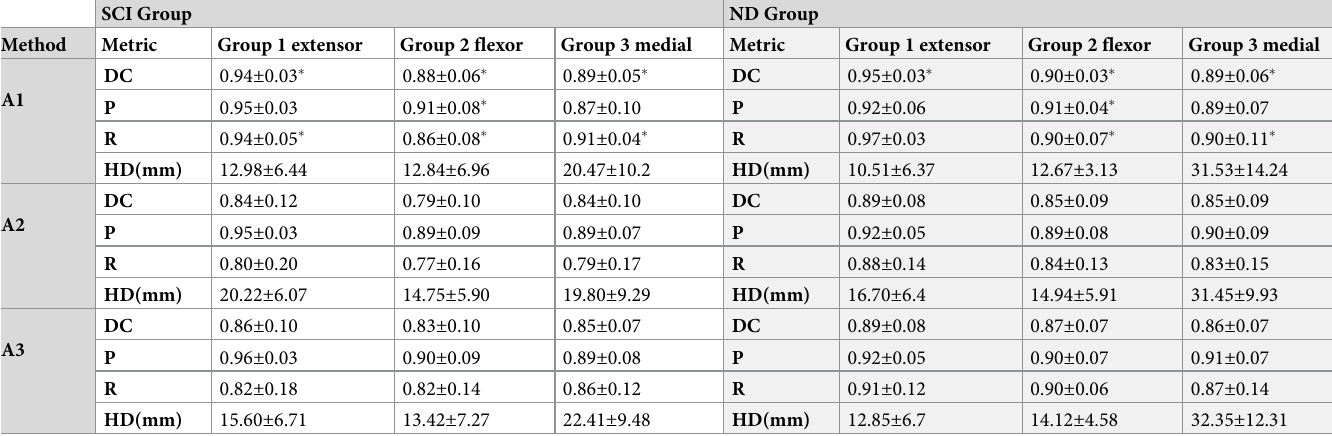
Table 2. Accuracy measures for segmenting three muscle compartments using the proposed method, ANTs and